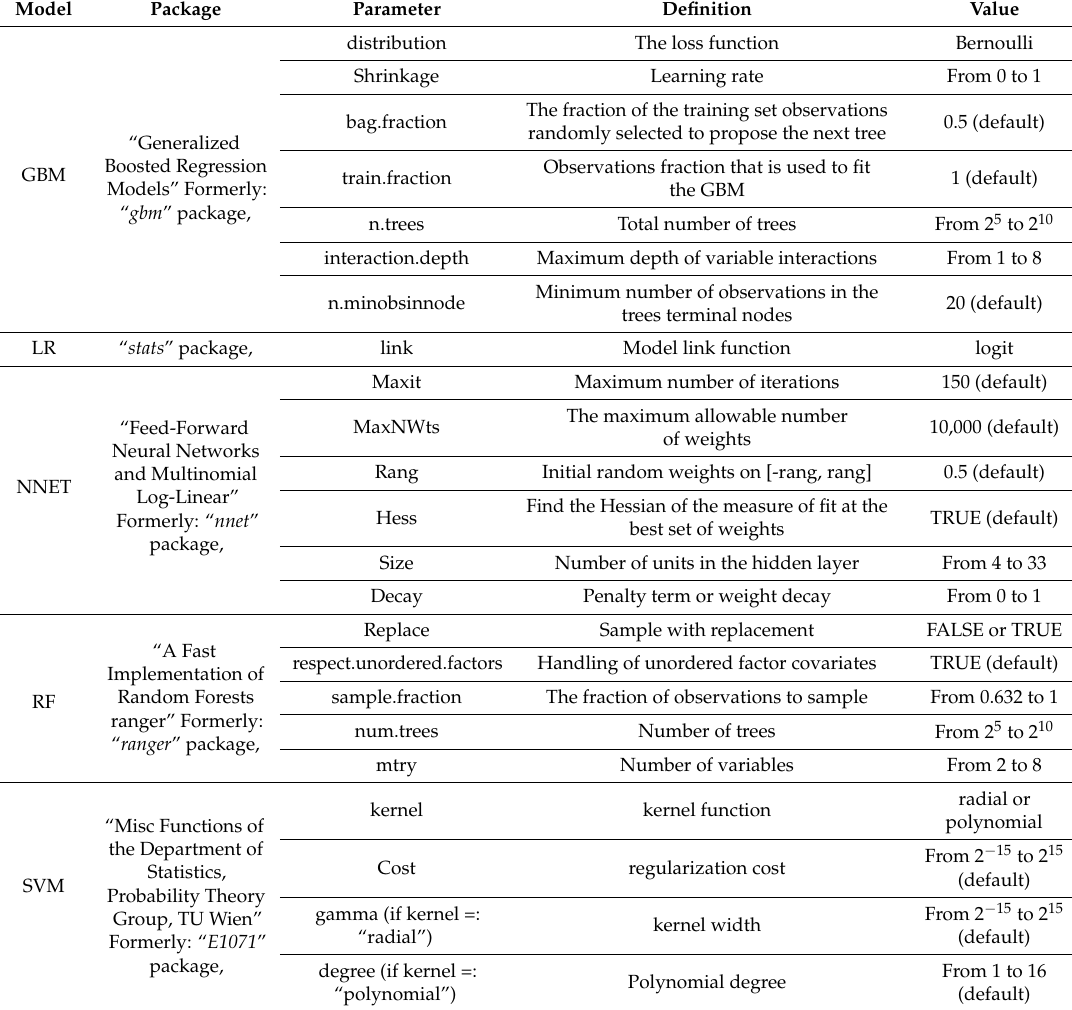
Figure 6. The general sequential model-based optimization approach. Table 3. The parameters set used by each model along with its respective values.